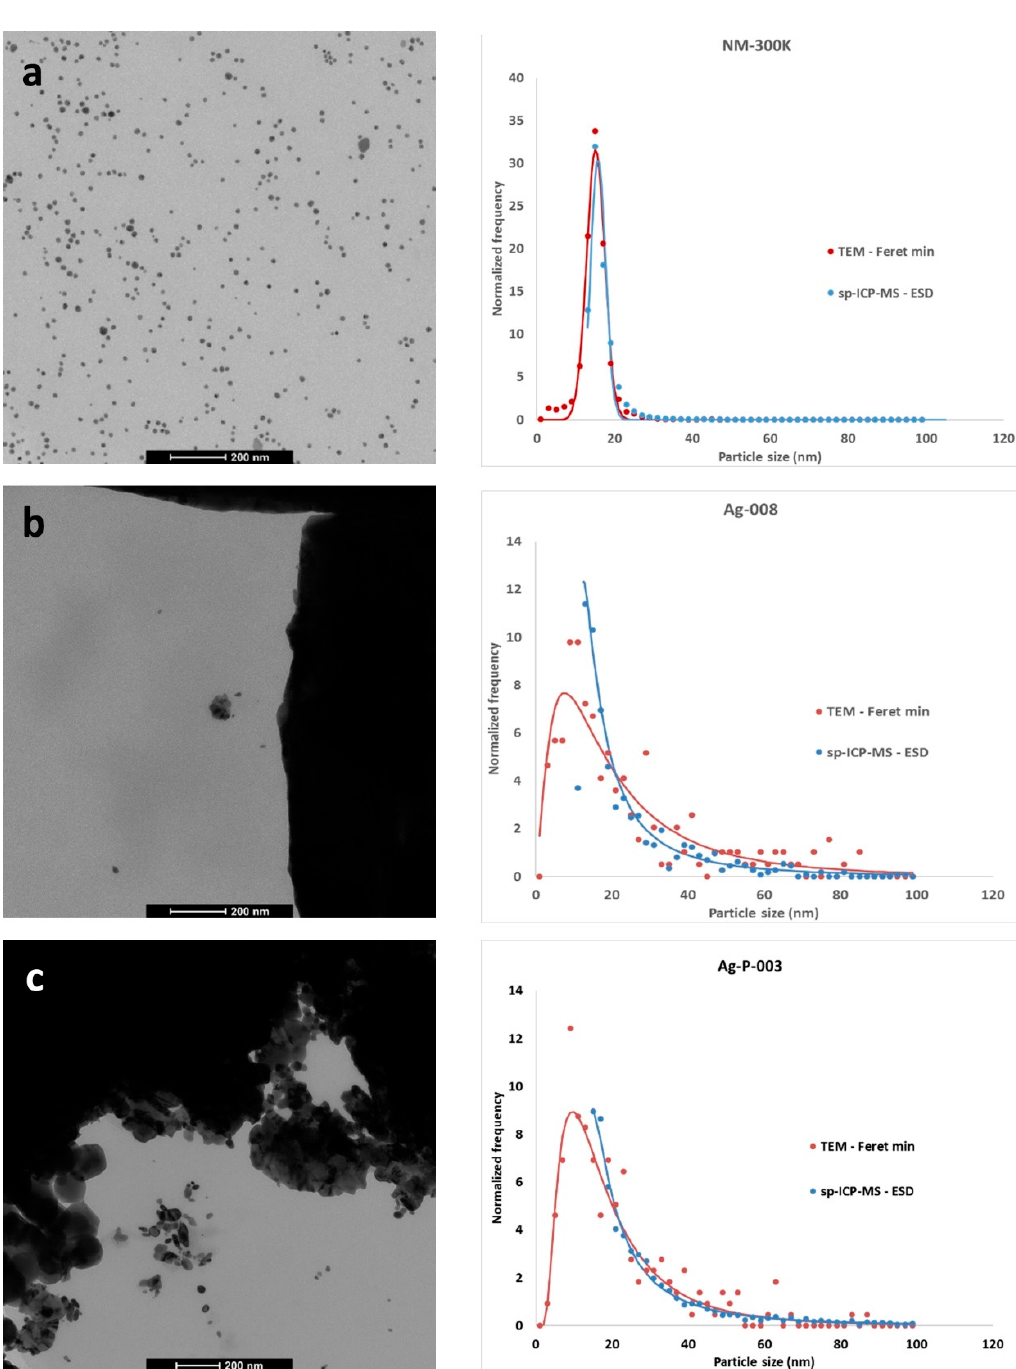
Figure 1. Representative TEM micrographs and silver particle size distributions determined by TEM and single ‐ particle inductively coupled plasma ‐ mass spectrometry (spICP ‐ MS) for ( a ) a colloidal dispersion of silver nanoparticles (AgNP) (NM ‐ 300K); ( b ) a pristine E174 food additive (Ag ‐ 008); and ( c ) an E174 ‐ containing food product (Ag ‐ P ‐ 003). ESD: equivalent spherical diameter.